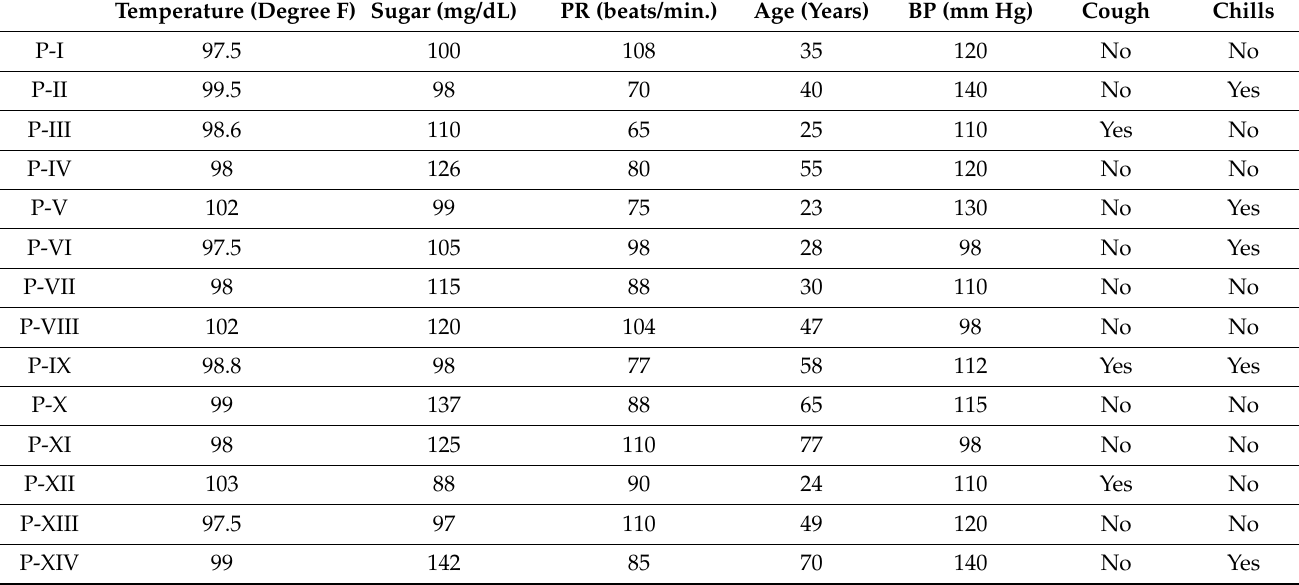
Table 1. Data of dengue-infected